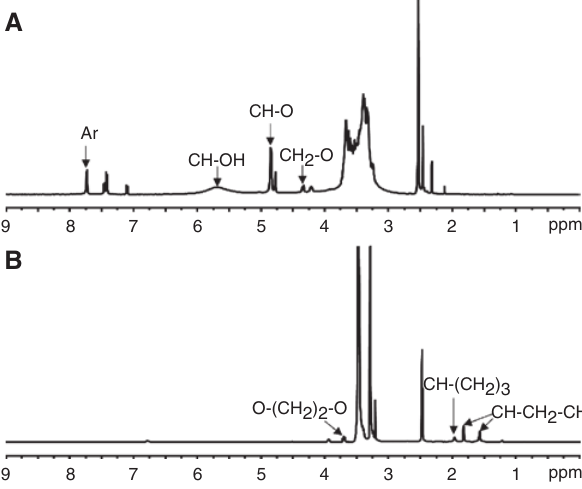
Figure 2: 1 H Nuclear magnetic resonance (NMR) (DMSO-d6, δ in ppm) spectra of (A) mono-6-deoxy-6-(p-tolylsulfonyl)-CD (6-TsO-CD) and (B) adamantylamine-polyethylene glycol (APEG).